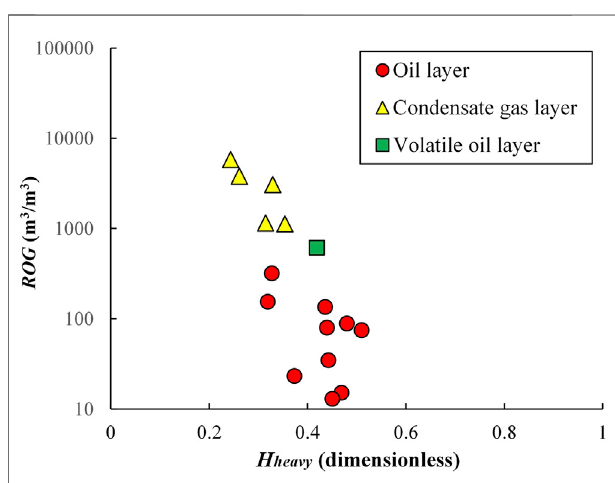
FIGURE 3 | Correlation between production gas-oil ratio and Tg/C1 of the layers of different hydrocarbon types in O oil fi eld.